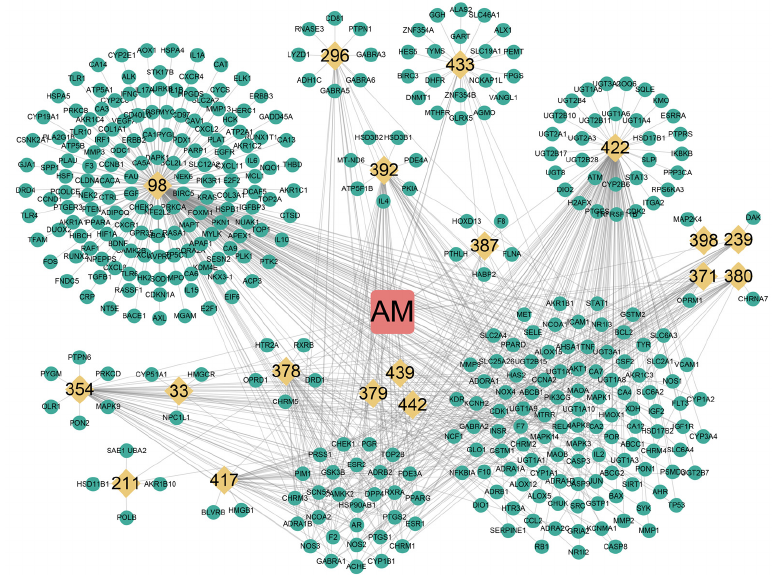
Figure 2. Construction of drug-compound-target network. The orange squares, yellow diamonds, and green dots represent the drug, the ingredient, and the target, respectively. AM: Astragalus membranaceus . The MOL ID of a compound was abbreviated to the last three digits.